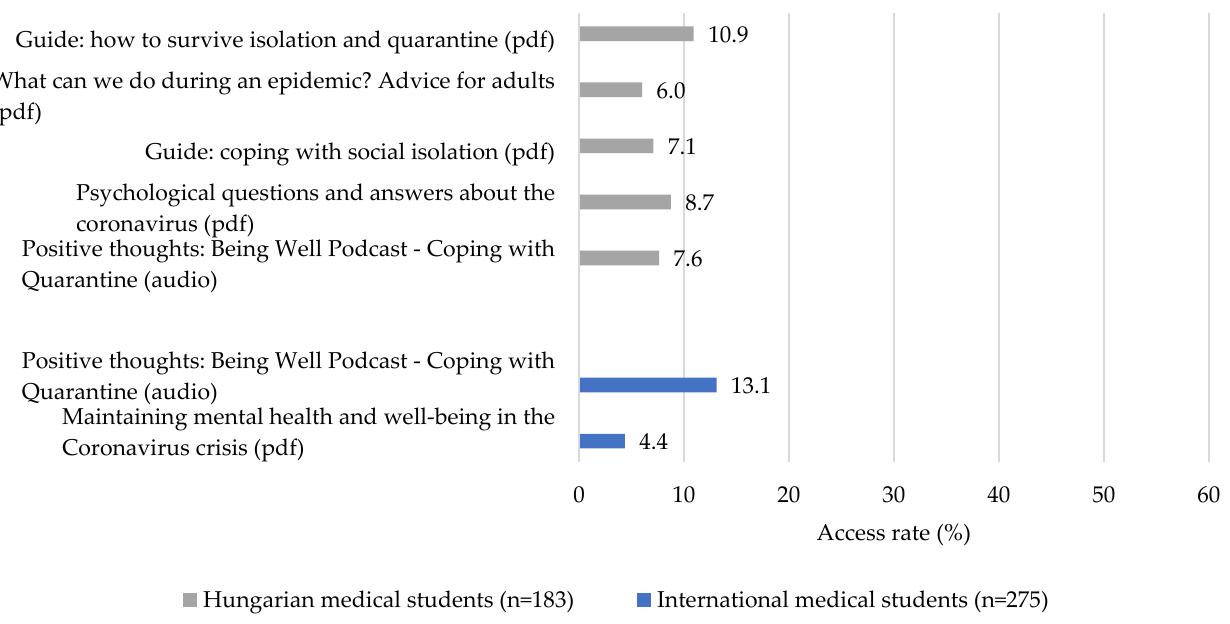
Figure 1. Access rate of the main content categories by course type; ** p < 0.001.